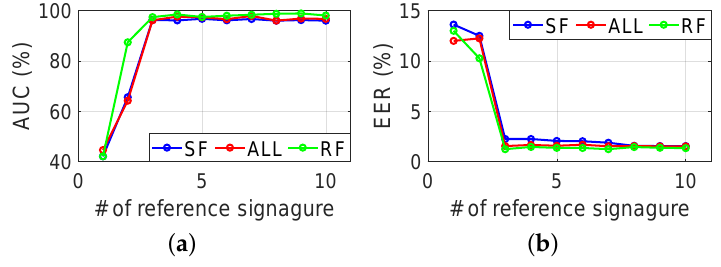
Figure 9. ( a ) AUC and ( b ) EER for various reference